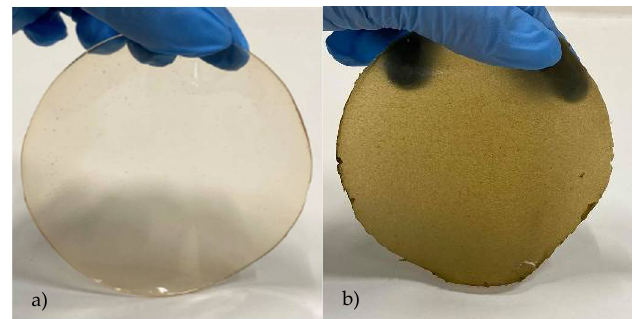
Figure 1. Developed films: ( a ) control film; ( b ) film with S. ramosissima .